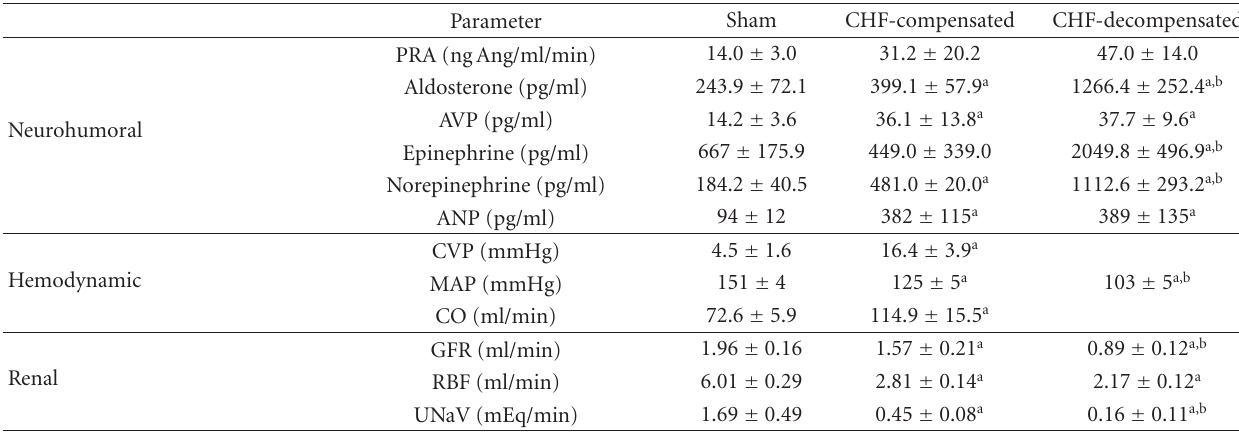
Table 1: Neurohumoral, hemodynamic and renal characteristics of sham operated rats and rats with compensated and decompensated CHF (see [7, 8, 10, 12, 17]).